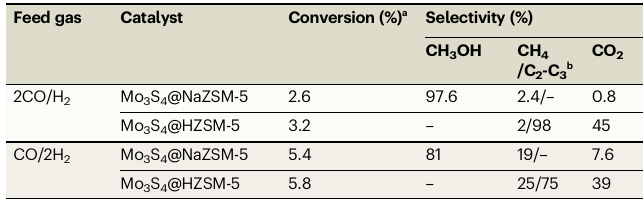
Table 3 | Catalytic syngas conversion over Mo 3 S 4 @NaZSM-5 and Mo